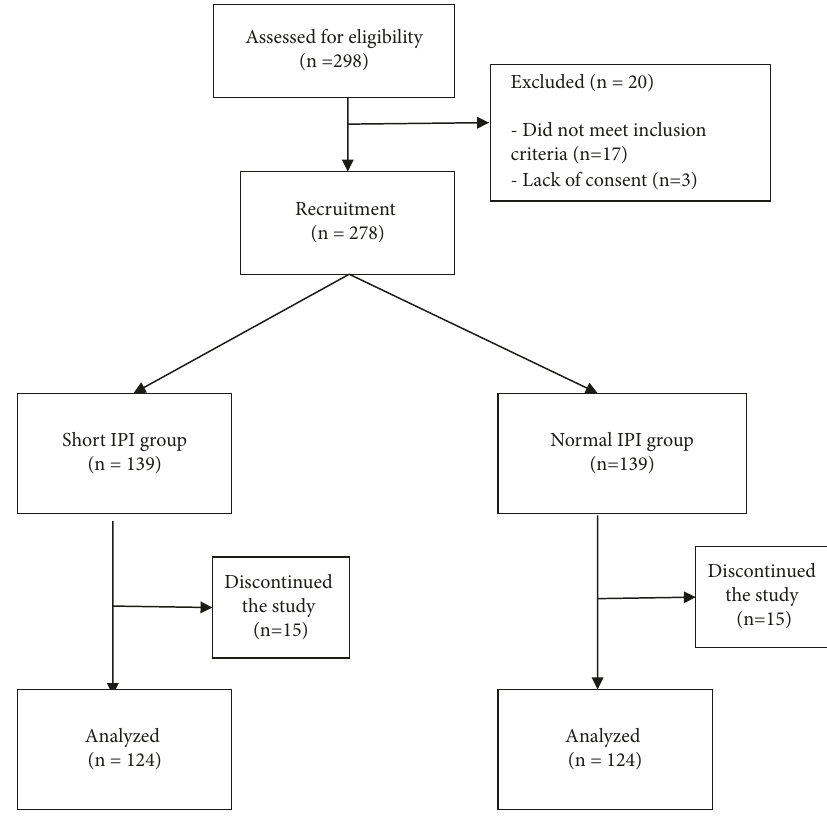
Figure 1: Flowchart of the study